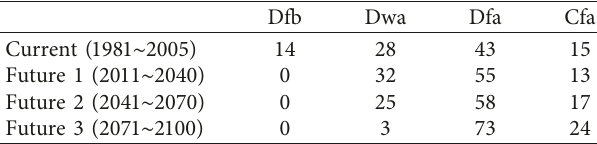
Table 4: Projection of shifting climatic zones in the future under the RCP climate change scenario (unit: